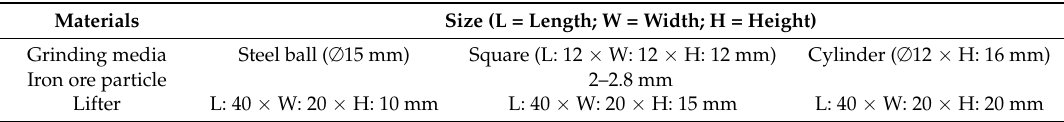
Table 2. Material properties.